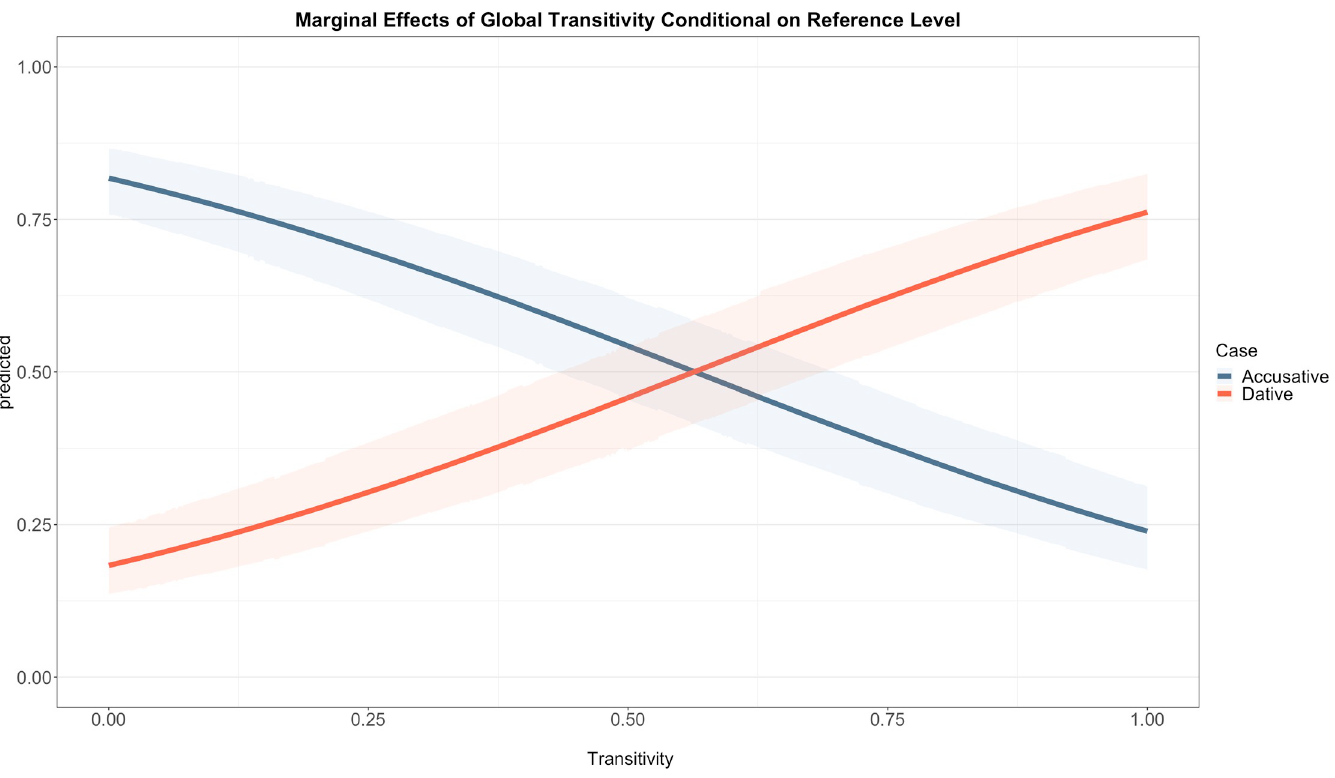
Fig 4. Marginal effects of the Transitivity Index conditional on the reference level of the other predictors. For Set 1 the reference levels are P ERSON : non-3 rd , T ENSE : non-past , C AUSATIVE : hacer , N UMBER S UBJ : singular and for Set 2 P ERSON : 3 rd , T ENSE : past , C AUSATIVE : dejar , N UMBER S UBJ : plural . The y-axis represents the posterior predicted probability for the dative clitic and x-axis the Transitivity Index scaled to have standard deviation 0.5.